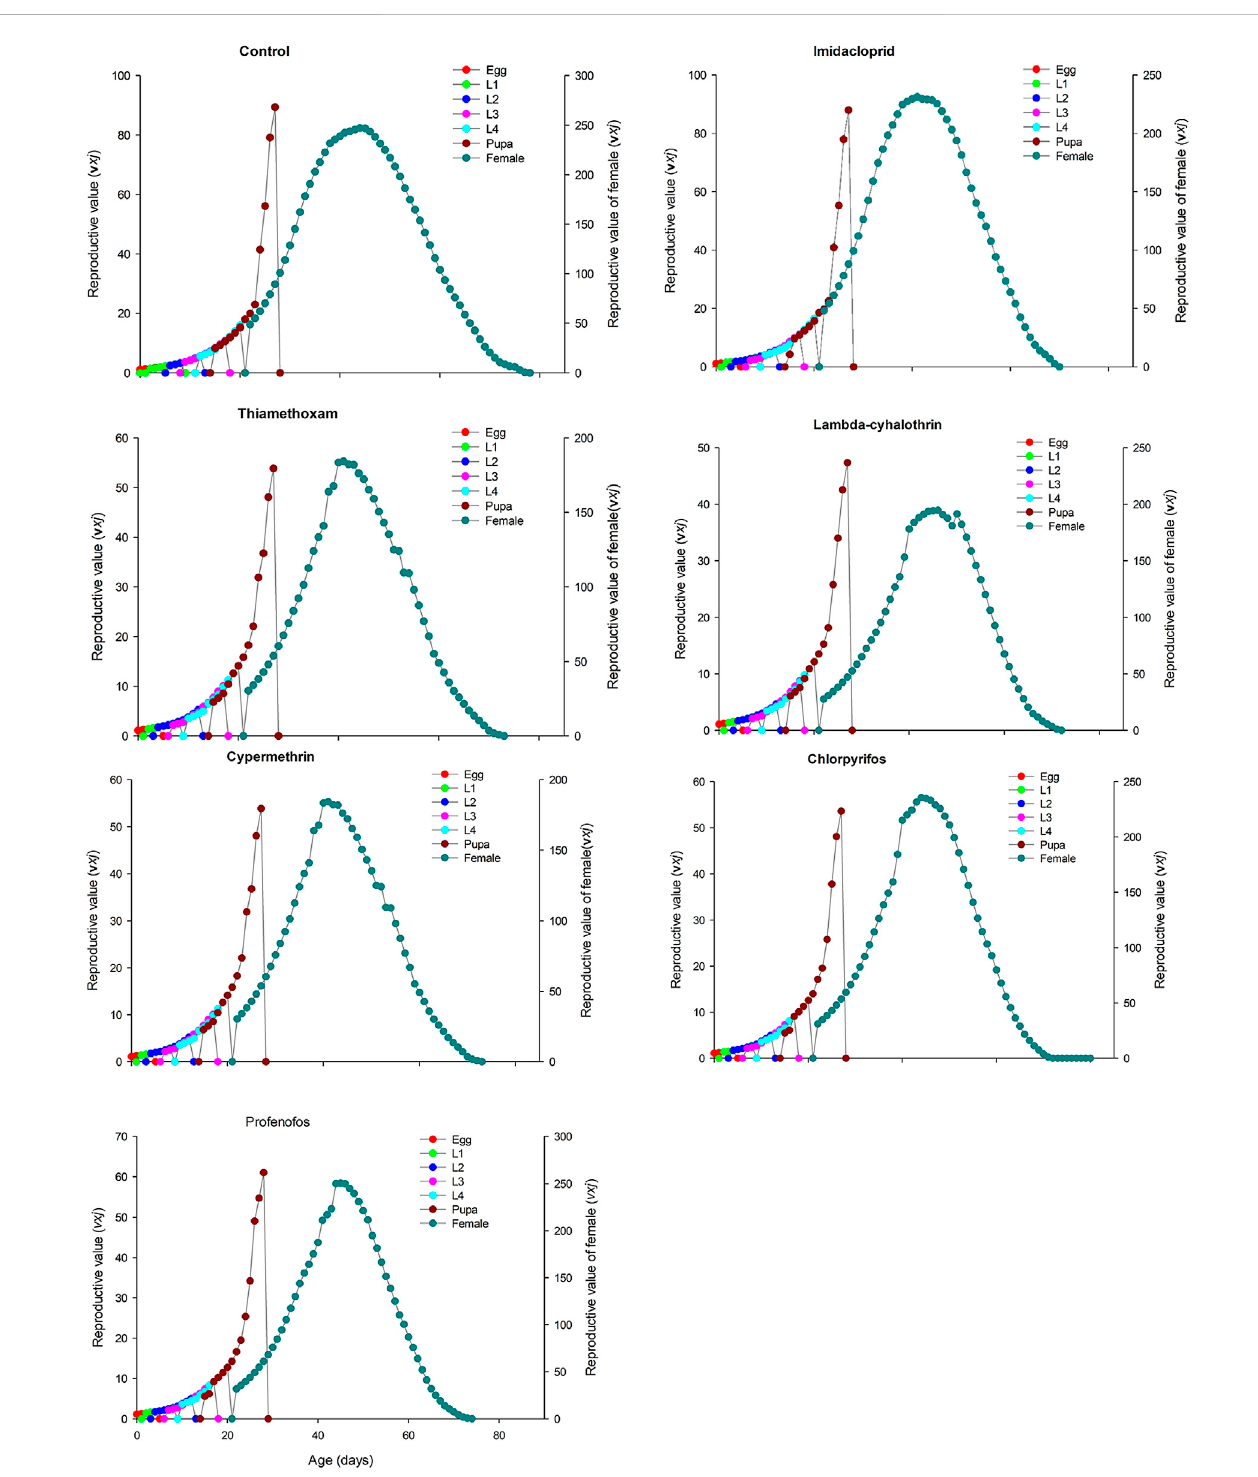
Age-stagespeci fi creproductivevalue( vxj )of Coccinellaseptempunctata (F 1 )treatedwithwater(control)andsublethalconcentration(LC 30 )ofsynthetic insecticides.